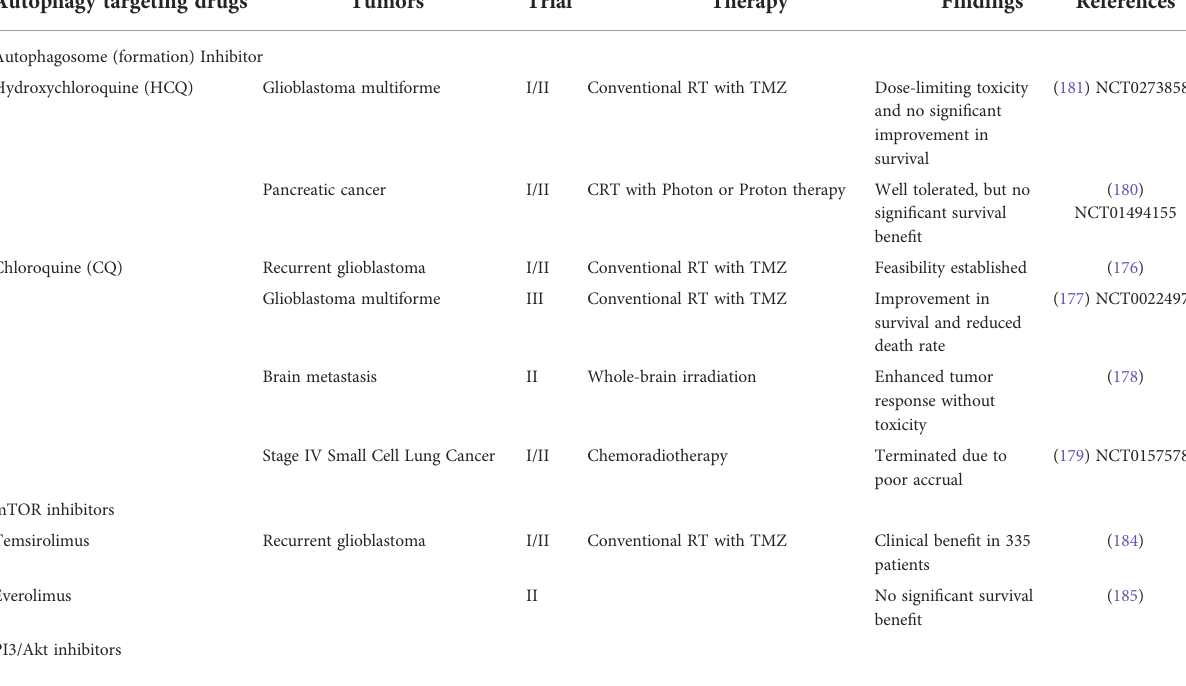
TABLE 3 Overview of the clinical trials targeting autophagy for improving radiotherapy of